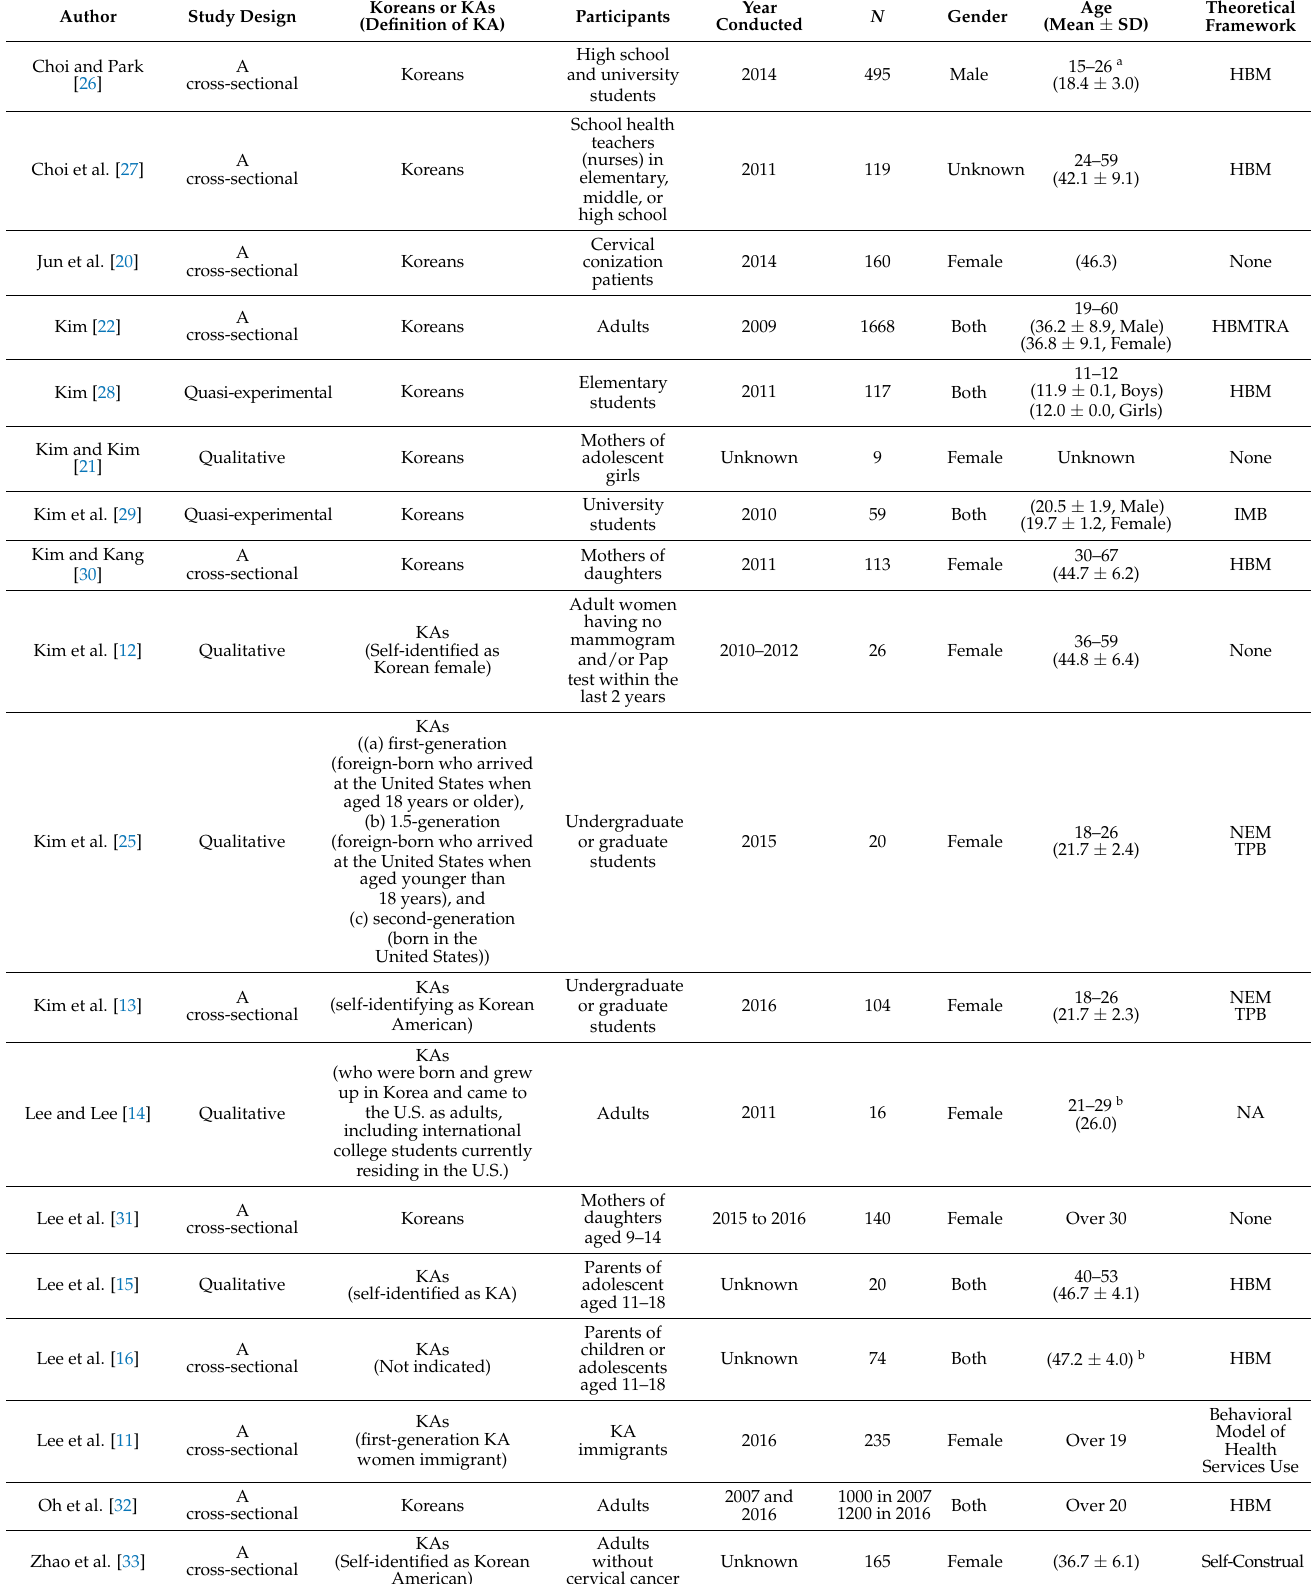
Table 1. Characteristics of the included